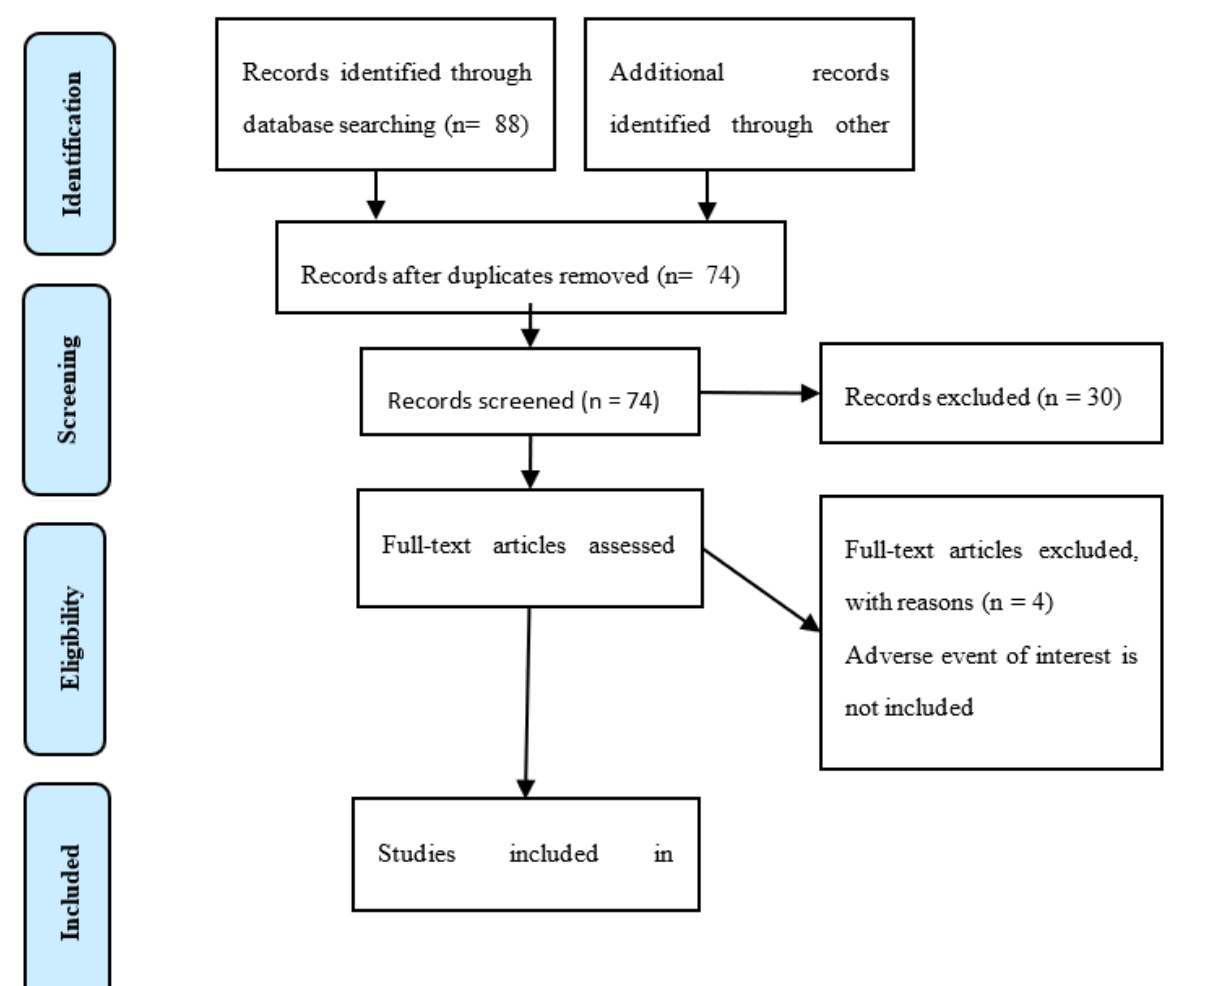
Figure 1. Selection of publications for inclusion in the review. From: Moher, D., Liberati, A., Tetzlaff, J., Altman, D.G., The PRISMA Group (2009). Preferred reporting items for systematic reviews and meta-analyses: The PRISMA Statement. PLoS Med 6(7): e1000097. doi:10.1371/journal.pmed1000097 For more information.